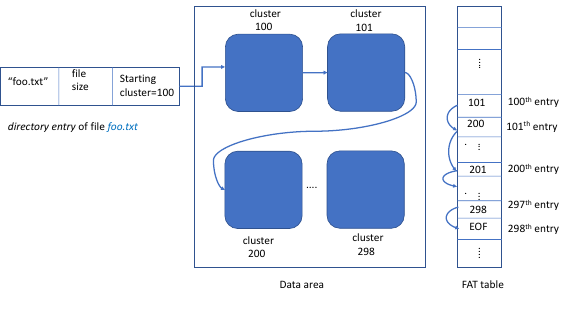
Figure 3. The layout of metadata and actual content of a file foo.txt is shown whereas the file has two fragments (cluster 100- 101 and cluster 200-298) as determined by the FAT